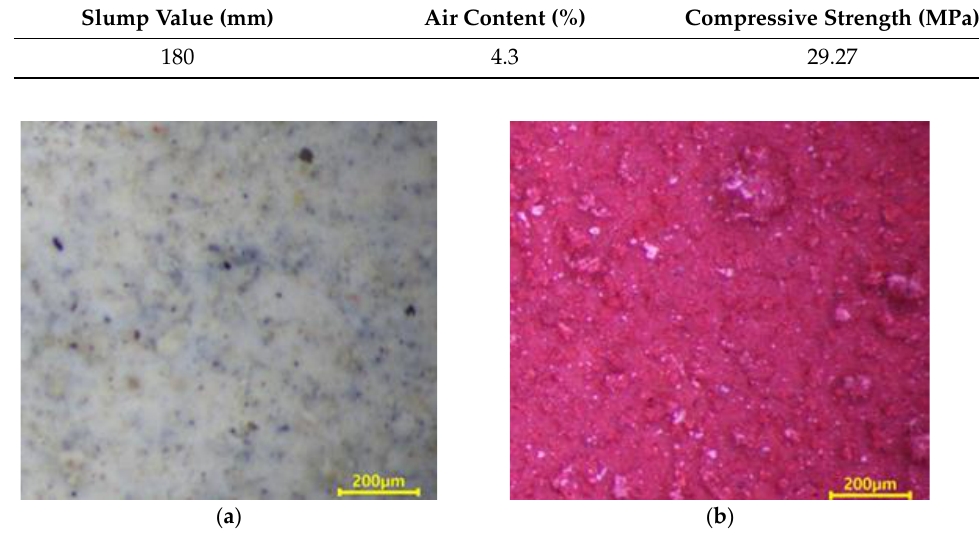
Table 4. Physical properties of the concrete.